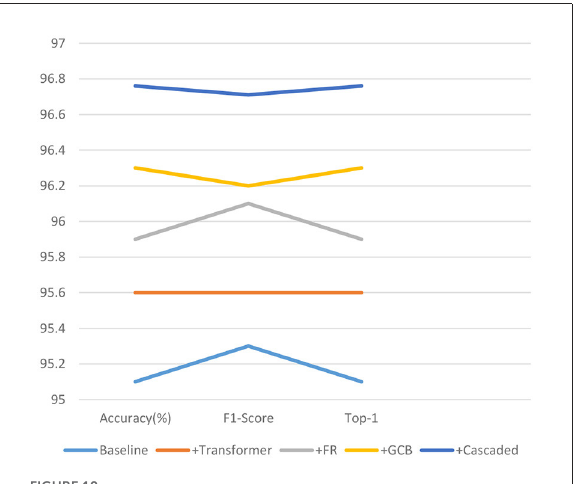
FIGURE10 Line graph of the validity analysis of the proposed model modules on the three quantitative